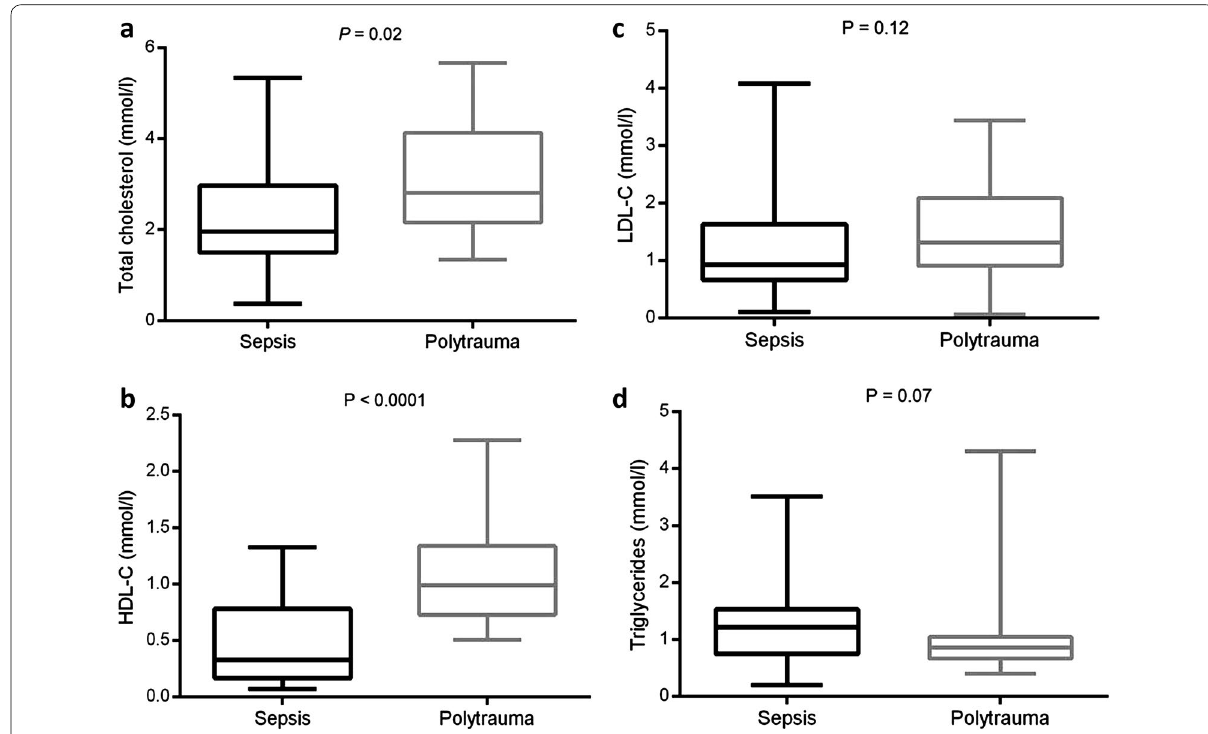
Fig. 1 Comparison of lipid levels between sepsis and trauma patients. a Total cholesterol; b HDL-C; c LDL-C; d triglycerides. Age-/sex-adjusted P values were reported. Minimum, 25th, 50th, 75th percentiles and maximum change values are